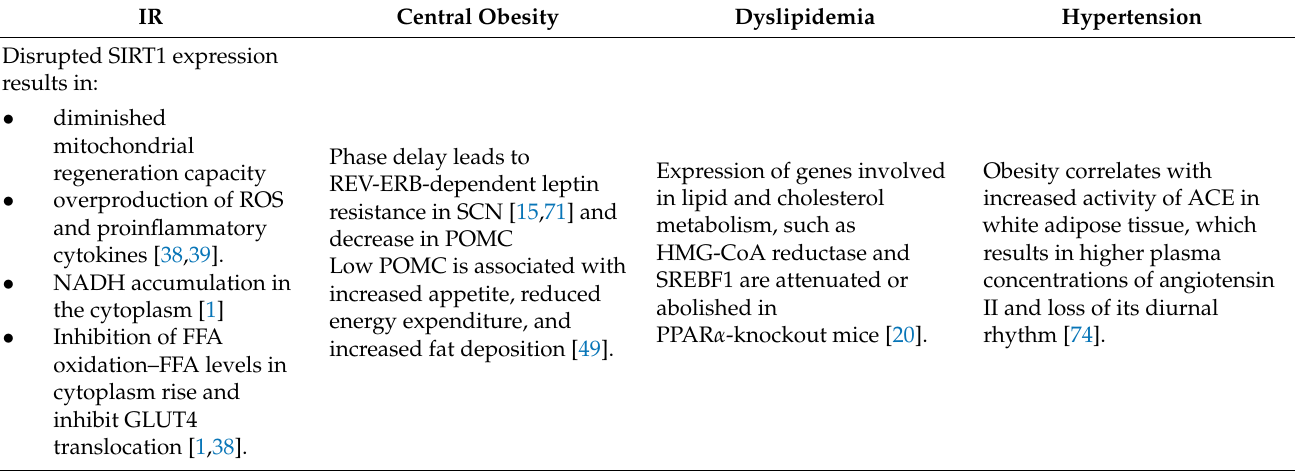
Table 1. MetS as a consequence of circadian rhythm